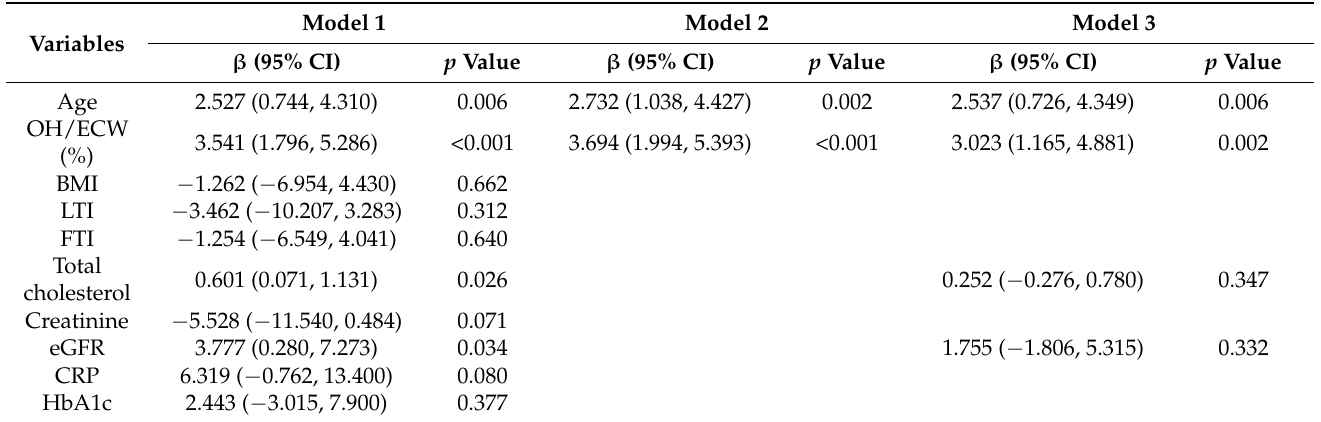
Table 2. Linear regression analysis of and clinical characteristics associated with serum GDF- 15/albumin ratio.